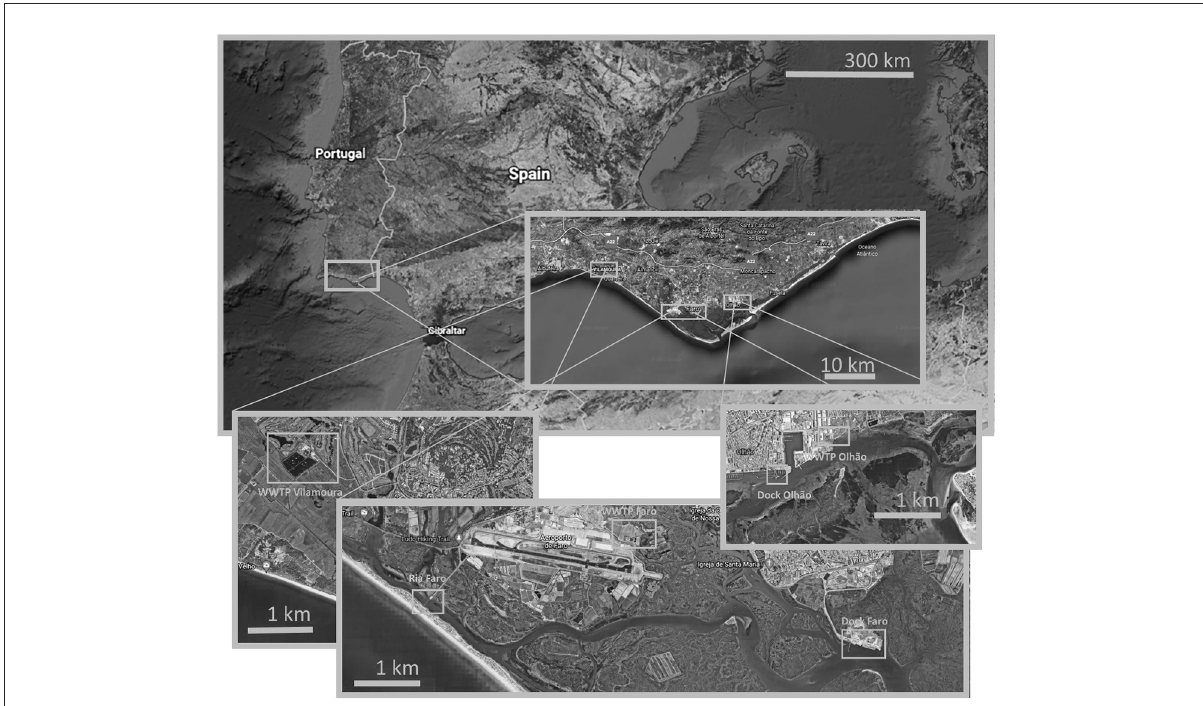
FIGURE1 Map of the Algarve region, Southern Portugal showing location of 3 sampling stations in the Ria Formosa lagoon (Ria Faro, Dock Faro and Dock Olhão) and 3 Water Treatment Plants (WWTP Vilamoura, WWTP Faro and WWTP